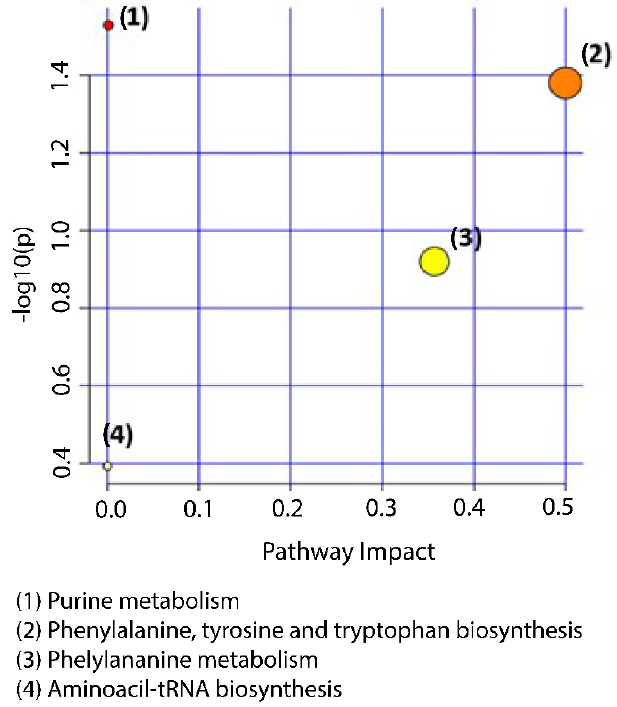
Figure 3. Metabolic pathway analysis of statistically significant metabolites between “healthy” and “inflammation” groups, combined in positive and negative ion mode. The pathways depicted are listed from 1 to 4 in descending order of importance, based on a combination of both the p -values (y-axis) and impact (x-axis). This was all performed according to the metabolic pathway analysis (MetPA) carried out in MetaboAnalyst 5.0.